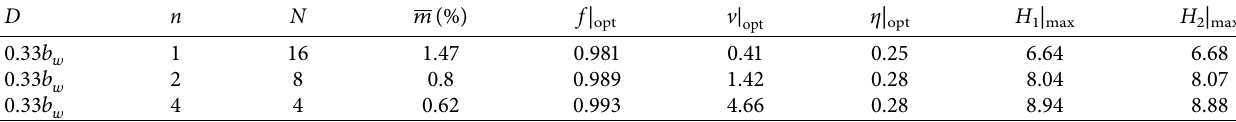
Table 7: Results from distributed TLMCD investigation.